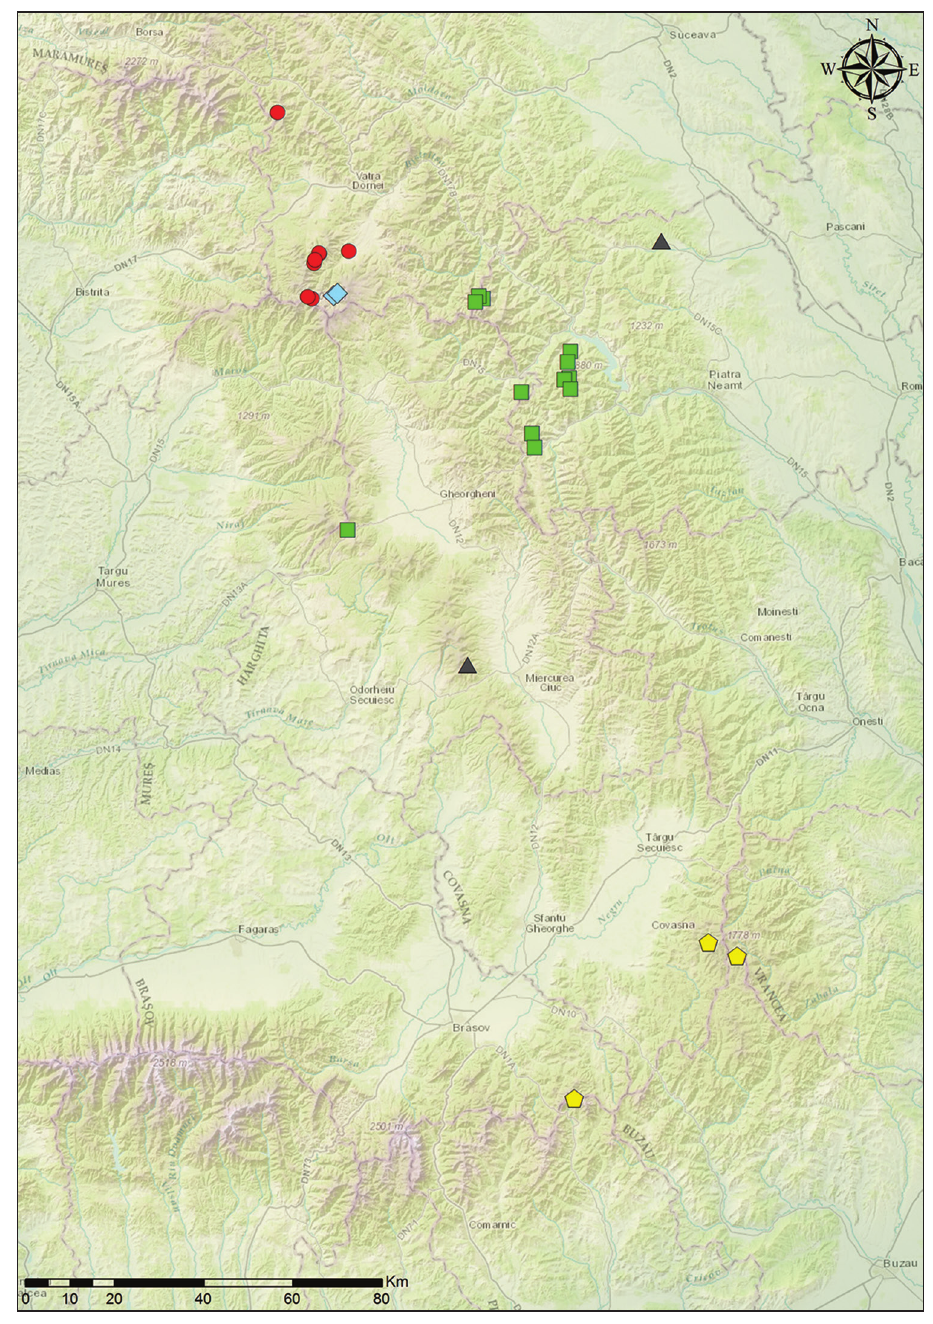
Figure 6. Geographic distribution of the Eastern Carpathian endemic Isophya species: red dots – I. bu- covinensis sp. n., yellow pentagons – I. ciucasi , green squares – I. dochia , blue diamonds – I. nagyi , black triangles – I. sicula